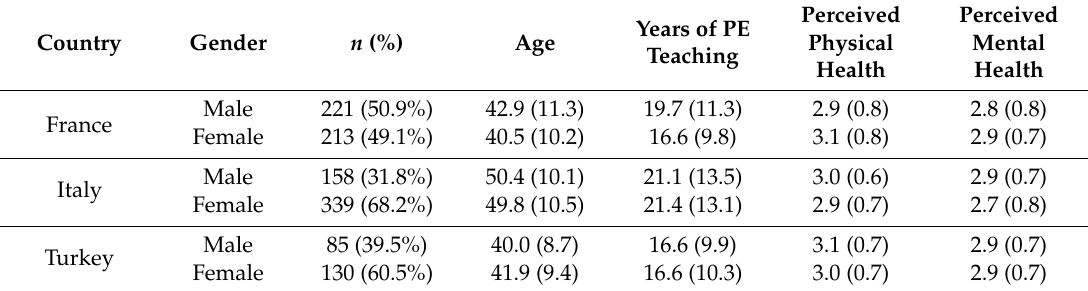
Table 1. Sociodemographic data and health perception of PE teachers, by country and gender.